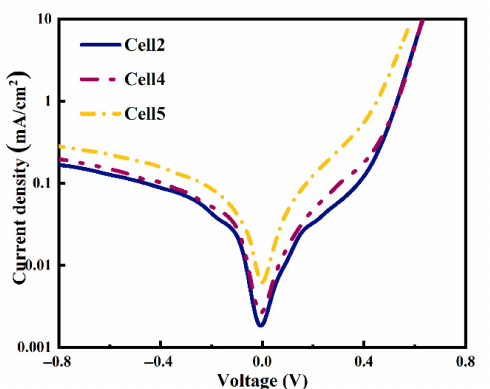
Figure 14. Dark J-V cures of the cells using different particle size Al powders.